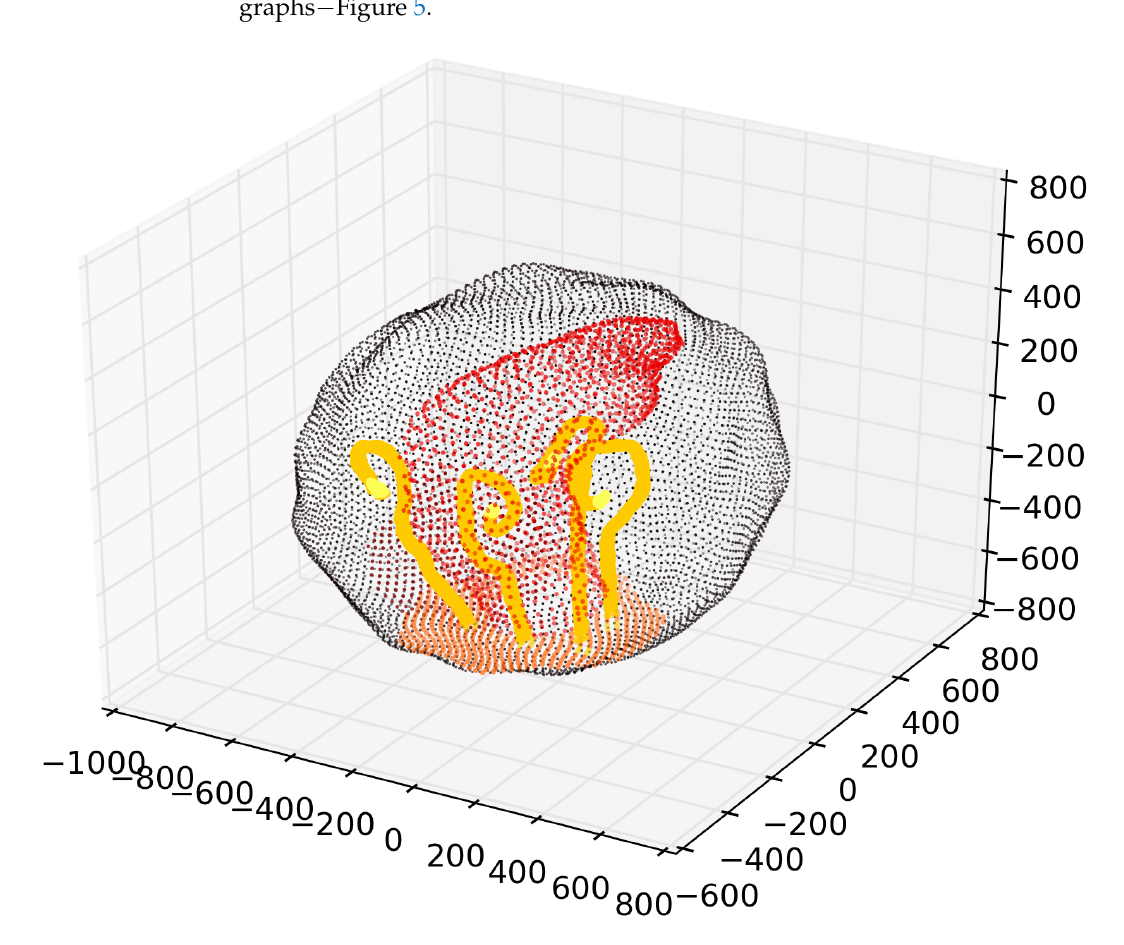
Figure 4. Real geometric model of the bouton with inner organelles—cell membrane ( black ), artificial cut ( orange ), mitochondrion ( red ) and microtubules ( yellow ) with their endings ( bright yellow ). The tick marks of the axes are placed at intervals of 200